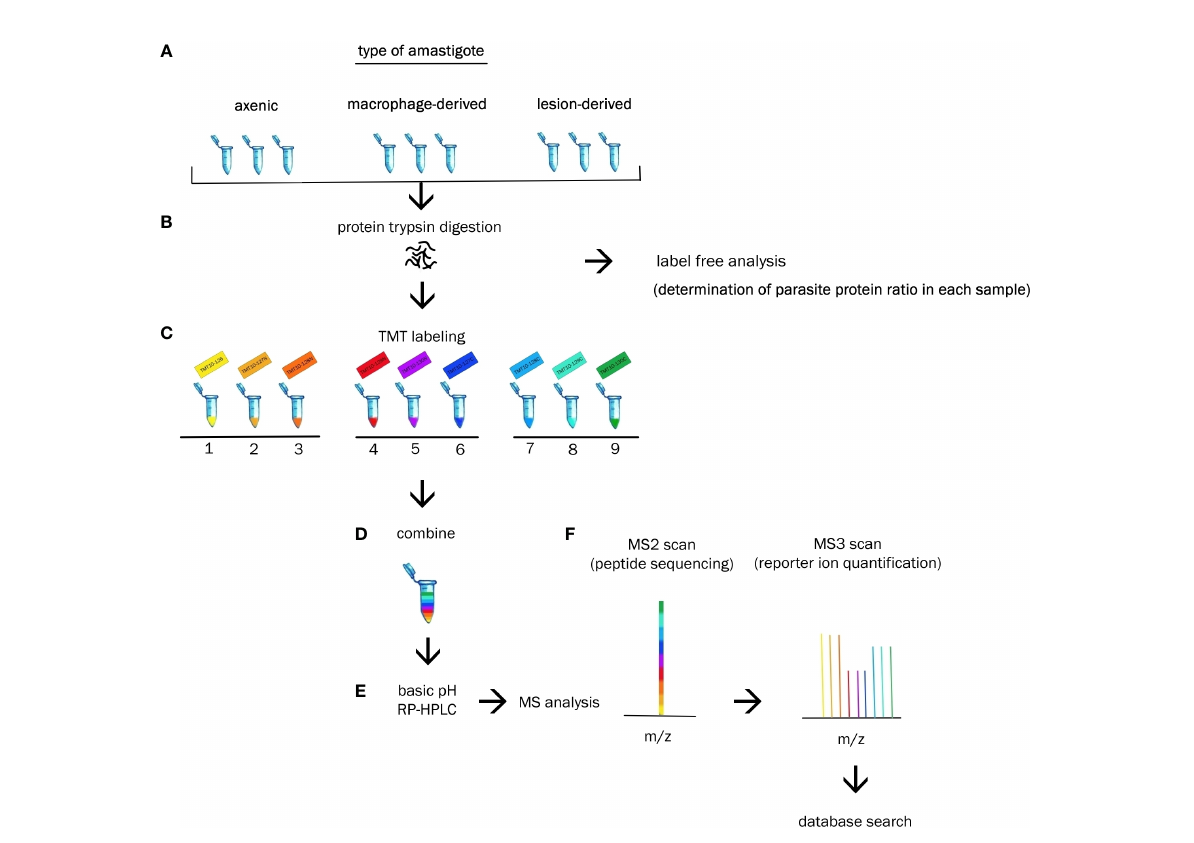
FIGURE 1 Experimental work fl ow. (A) Biologic triplicates of axenic, macrophage-derived and lesion-derived amastigotes were homogenized. (B) Extracted proteins from each sample were digested with trypsin and subjected to label free analysis to determine the percentage of Leishmania protein in each sample. (C) Each sample was labeled with a unique TMT10-plex reagent. (D) Resulting peptides were combined at equal ratios of parasite protein. (E) Peptides were fractionated via basic RP-HPLC separation. (E) Reversed-phase HPLC was performed prior to tandem MS analysis. (F) Identi fi cation and quanti fi cation of the proteins were performed using bioinformatics and statistical